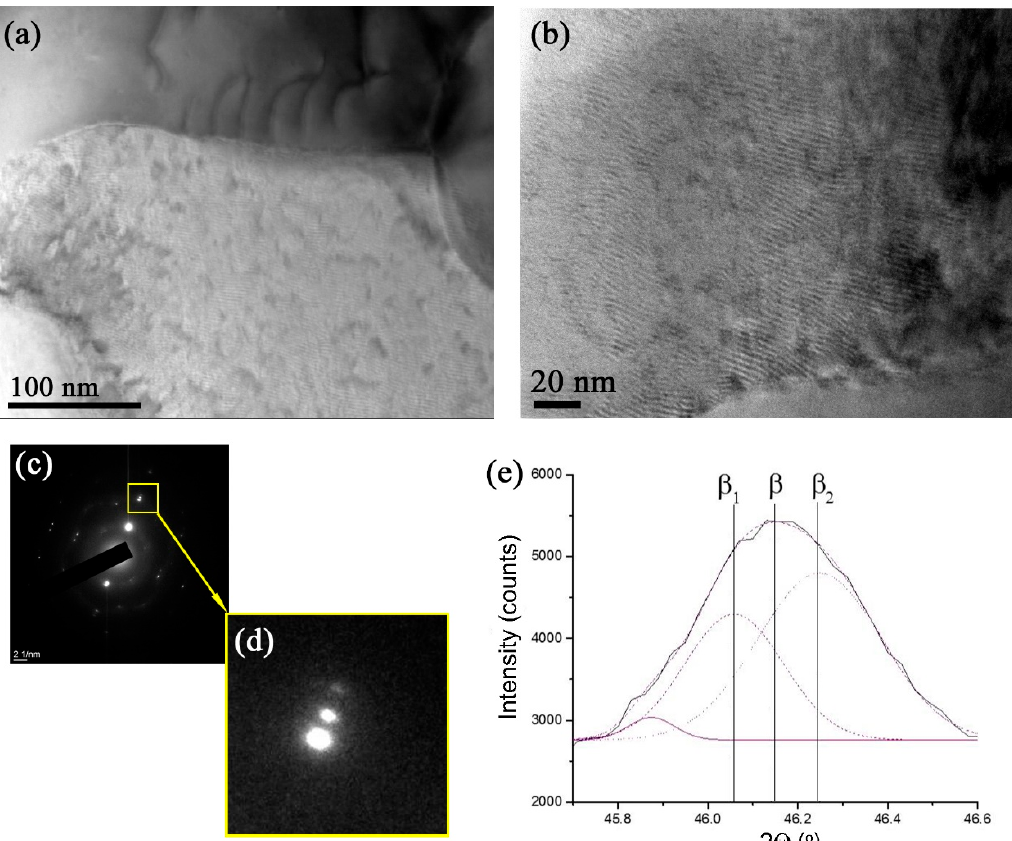
Figure 12. Microstructures of grains with modulated structures formed according to the spinodal decomposition ( a , b ). A SAED pattern ( c ) with an enlarged view of the (–202) β -Ti reflection ( d ) and deconvolution of an XRD (110) β peak. β 1 and β 2 are Ti phases that emerge from β by spinodal decomposition. It may be suggested that spinodal decomposition occurred in supersaturated β SS grains via clustering and formation of copper-lean β 1 and copper-enriched β 2